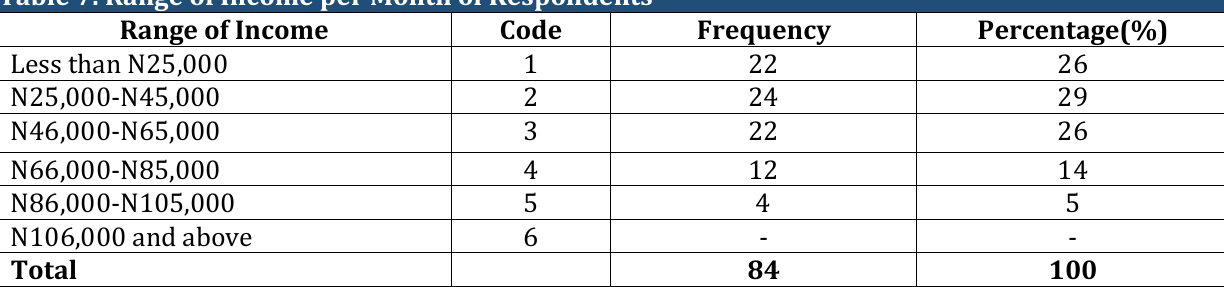
Table 7. Range of Income per Month of